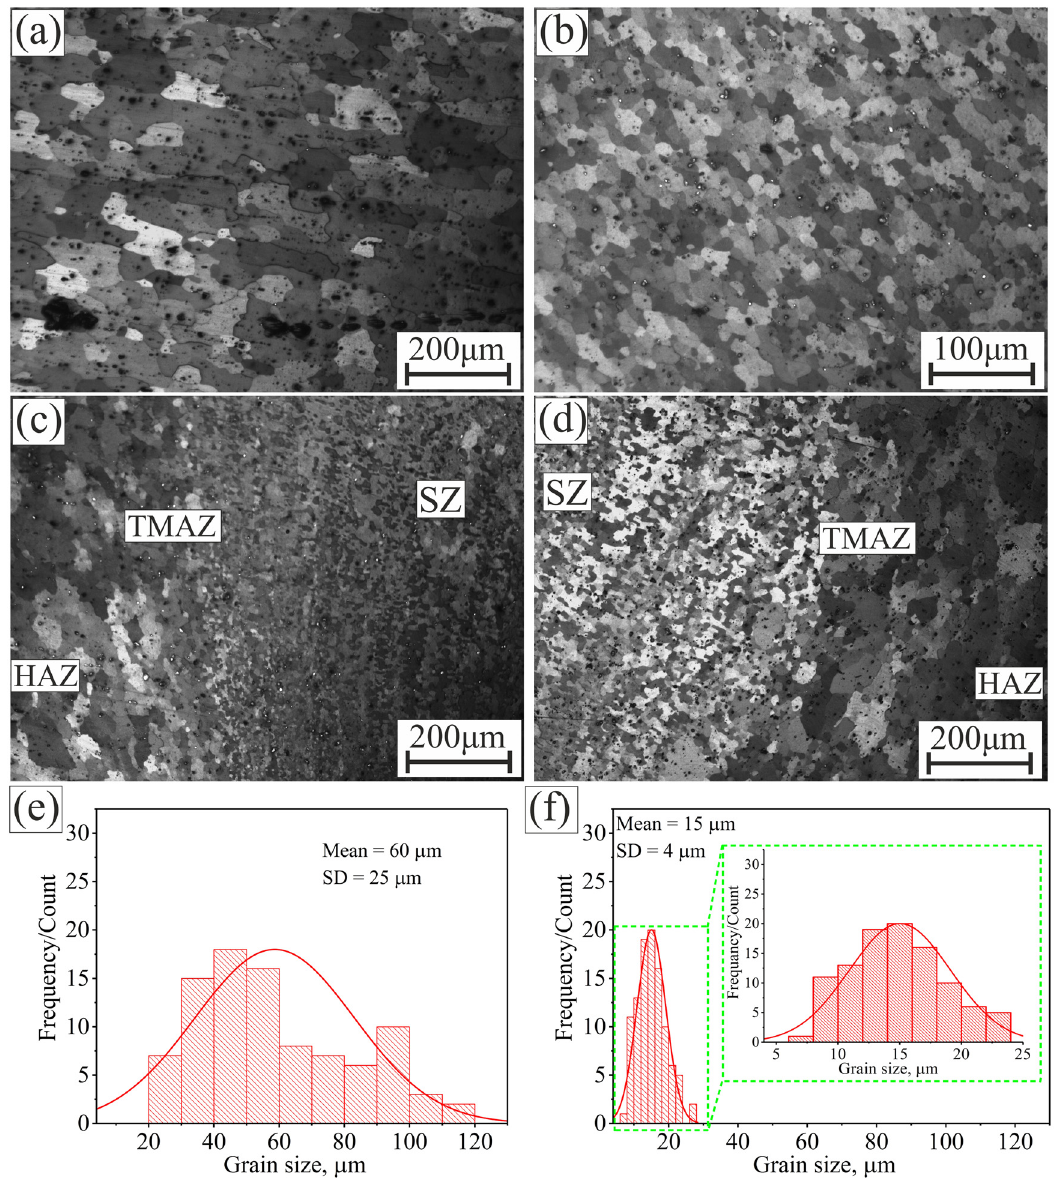
Figure 3: Microstructure of ( a ) as - received Al 5251 alloy, ( b ) after FSP, ( c ) advancing side, and ( d ) retreating side; ( e ) grain size distribution of the as - received alloy and ( f ) grain size distribution of SZ after